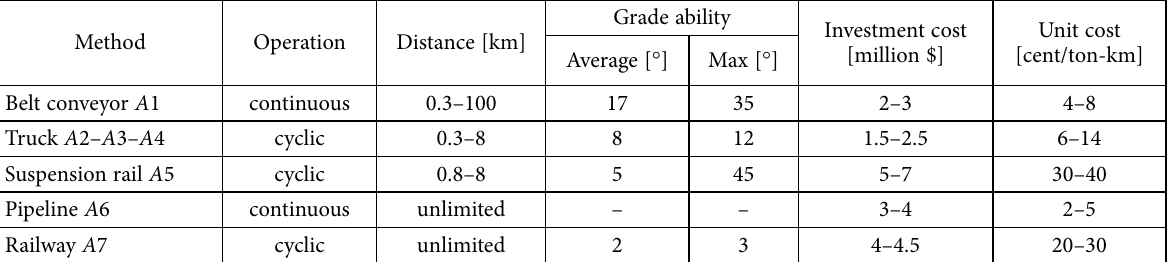
Table 1. Characteristics of haulage techniques (Karpuz 2005; Thompson, Raymer 1981)